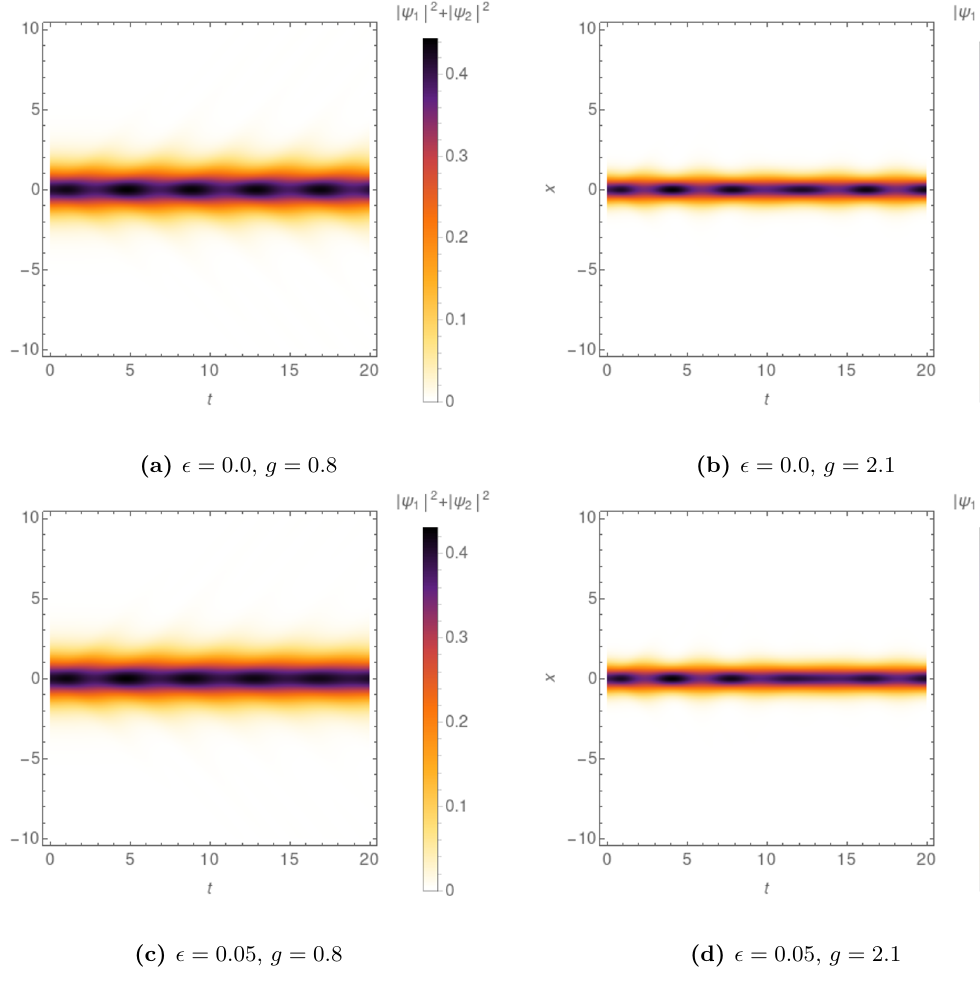
Figure 4. Evolution of the fermion density by numerically solving the equations of motion. The fermion starts at the zero mode.